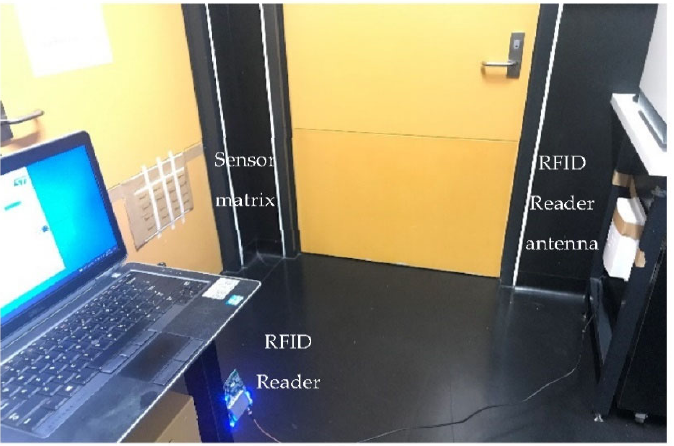
Figure 9. 2D RFID tag array indoor applications test platform for DOA measurements.